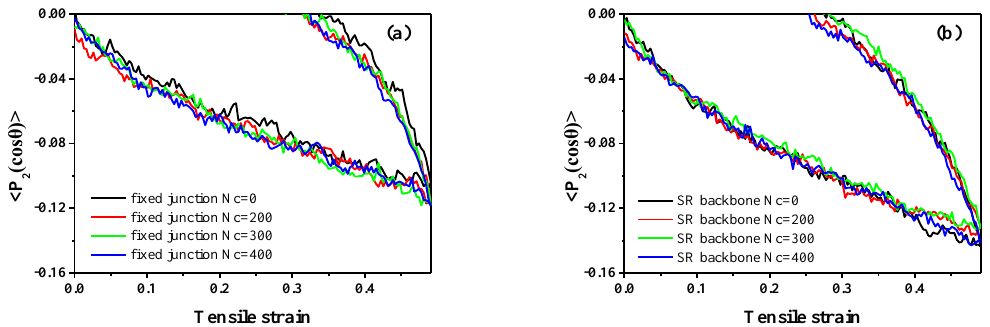
Figure 13. The orientation of the bond, (cid:104) P 2 ( cos θ ) (cid:105) , in backbone during the compression-recovery deformation in the z direction for different number of cross-linked bonds; Nc within ( a ) the fixed junction systems and ( b ) SR systems.